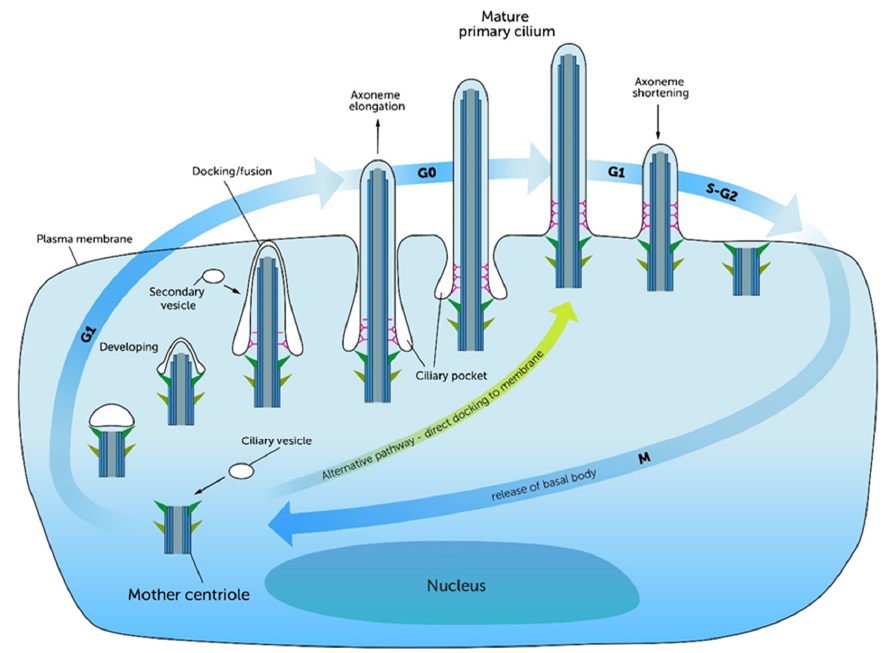
Figure 3. Starting from the mother centriole, ciliogenesis begins intracellularly. In the G1 phase of the cell cycle the mother centriole docks to ciliary vesicles or alternatively directly to the cell membrane. The resulting Basal Body forms the basis of the elongating cilium. By nourishing the ciliary membrane with secondary vesicles, the formation of the transition zone takes place. After fusion with the cell membrane, the ciliary gate is formed and the extension of the axoneme starts. The cilium reaches its full length and complete structure in the G0 phase of the cell cycle. The complete ciliary length is achieved through an equilibrium of assembling and disassembling processes. When the cell re-enters the cell cycle, the axoneme is degraded and the Basal Body is formed back to the mother centriole. Thus, the centriole is ready to run through mitosis again. Image modified from Molla-Herman et al. (2010)